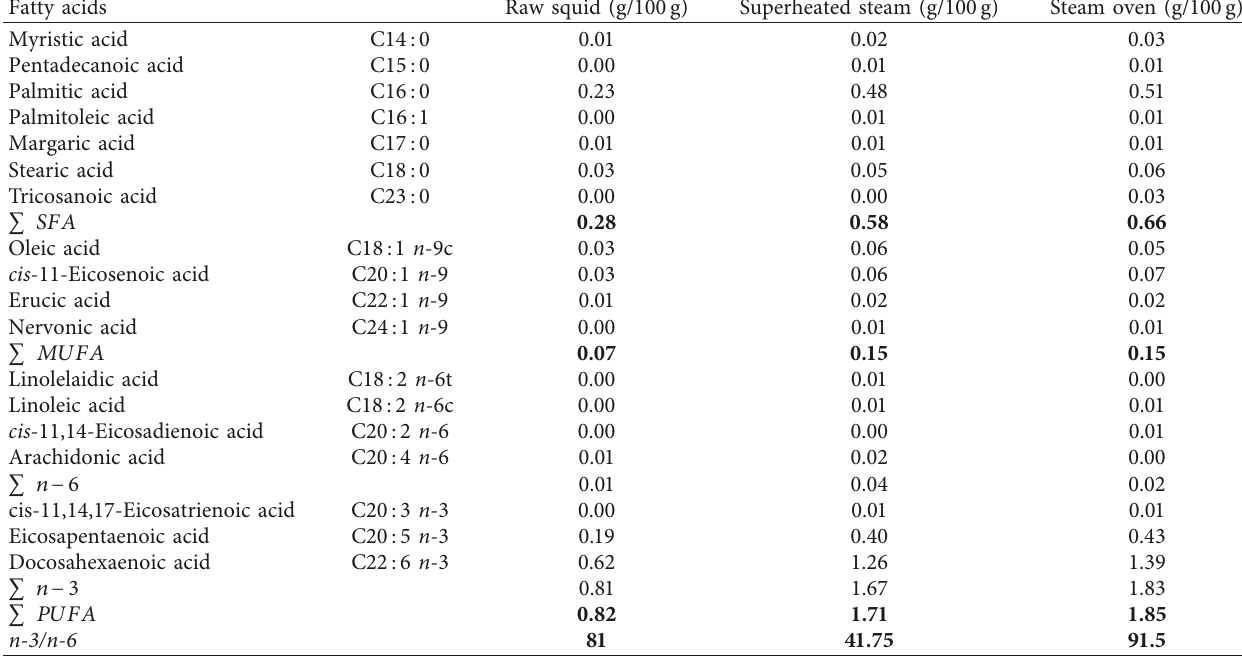
Table 6: Fatty acids composition of raw, superheated steam-treated, and steam oven-treated squid. Fatty